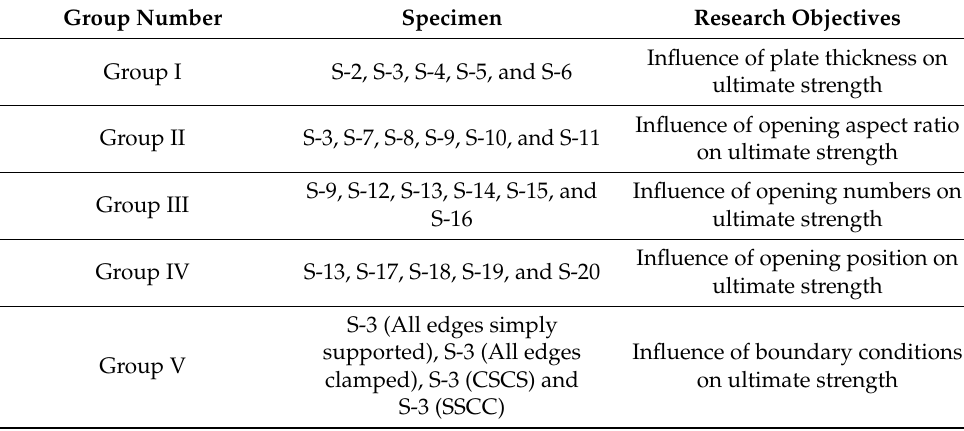
Table 2. Assigned groupings of the modelled